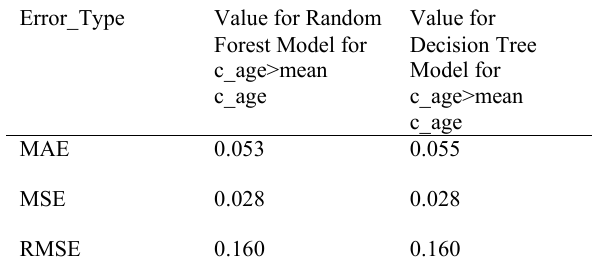
Table 6. Values of MAE, MSE, RMSE for overall data set for the Random Forest and Decision Tree Models